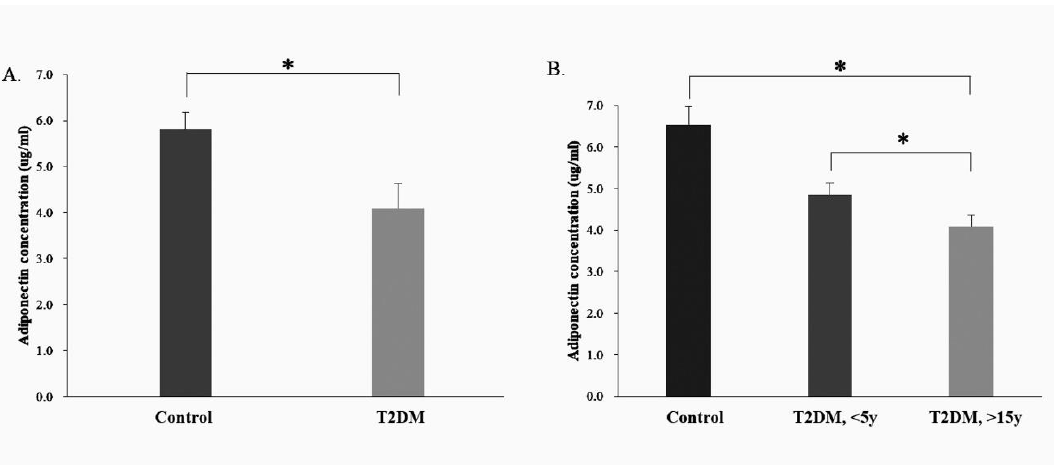
Figure 4. Measurement of the adiponectin protein concentrations in the serum of control group and T2DM patients using ELISA analysis. ( A ). Serum adiponectin expression in the human control and T2DM groups; ( B ). Serum adiponectin expression in the human control and different course of T2DM groups (<5 Years and >15 y Disease Course). * p < 0.05, for the comparisons indicated.